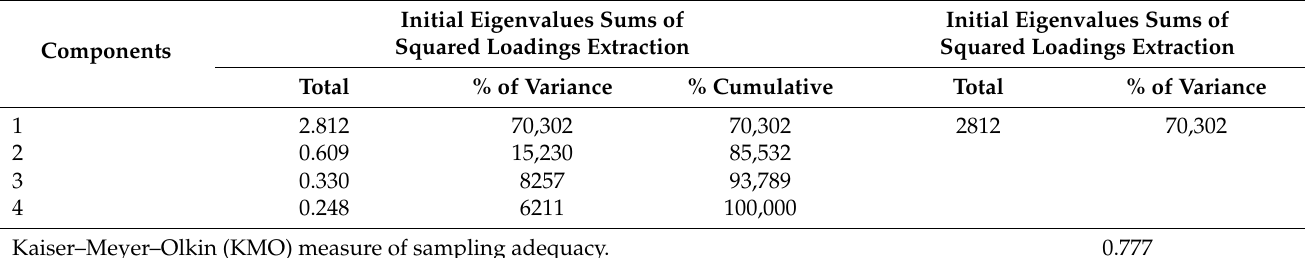
Table 3. Factorial Analysis—Institutional Communication.